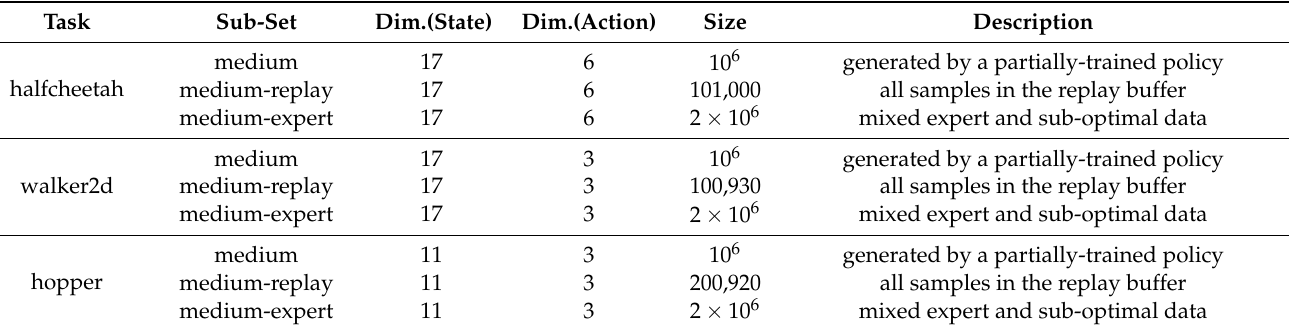
Table 5. Offline continuous locomotion tasks in D4RL.